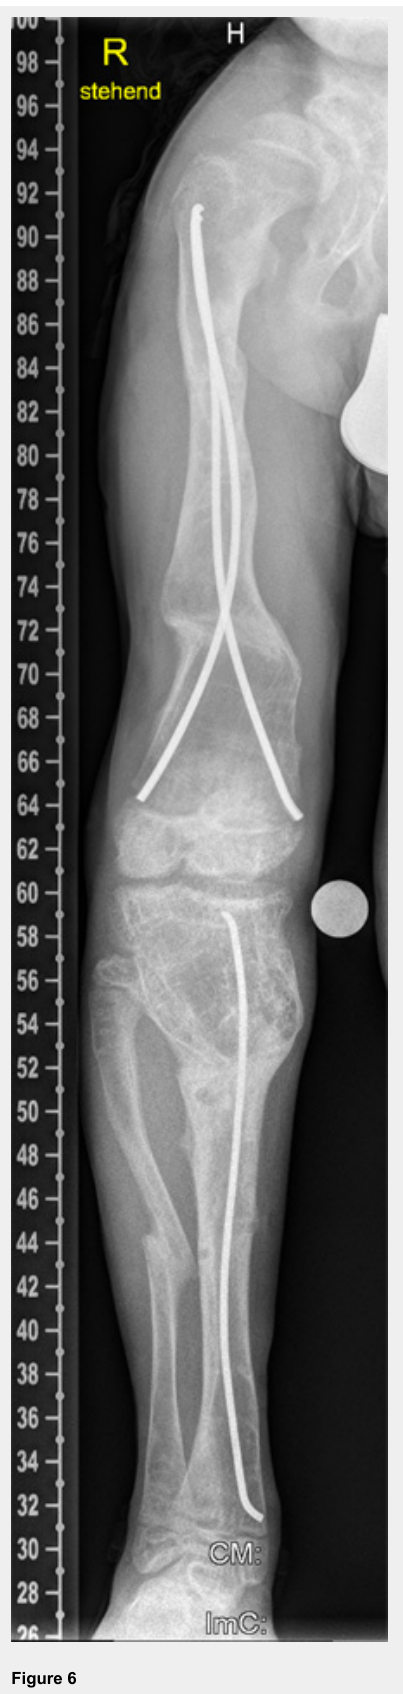
After consolidation and removal of the frame, a prophylactic nailing of the right femur and tibia was performed to obtain the